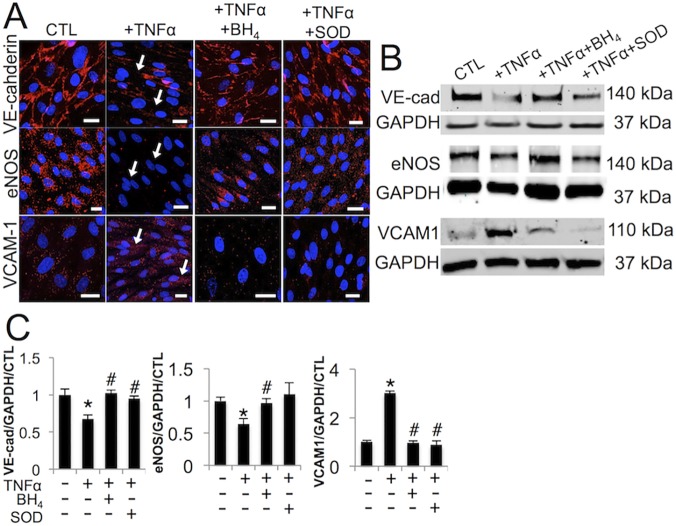
Blocking eNOS uncoupling mitigates TNFα-induced endothelial dysfunction and inflammatory response.
A, TNFα decreases VE-cadherin and eNOS expression in VEC over 48 hours (arrows), rescued by BH4 or peg-SOD. TNFα increases VCAM-1 expression in VEC over 48 hours, mitigated by BH4 or peg-SOD. B, Western blot analysis of VE-cadherin (VE-cad), eNOS, and VCAM-1 protein in same conditions as A, with GAPDH housekeeping protein. C, Quantification of western blot results, normalized to GAPDH and control, n = 3. * indicates p < 0.05 versus control, # indicates p < 0.05 versus TNFα. Scale bar = 20μm. Images representative of three independent experiments.